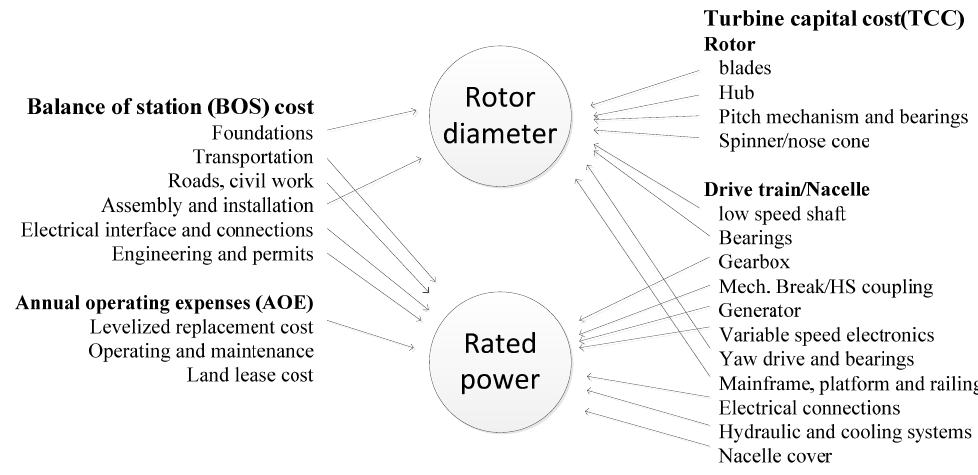
Figure 11. The iterative course for the optimization process considering rated power.